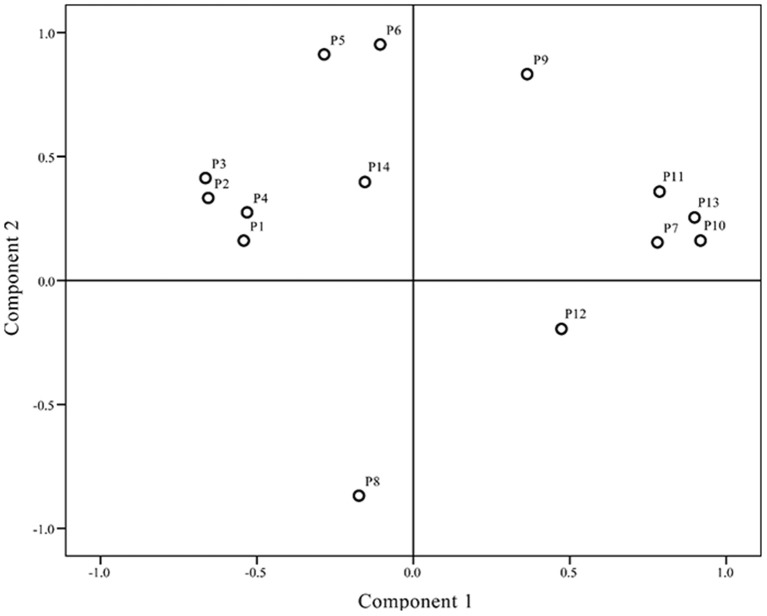
Scores plot generated from principal component analysis (PCA) of variables (peaks 1–14).